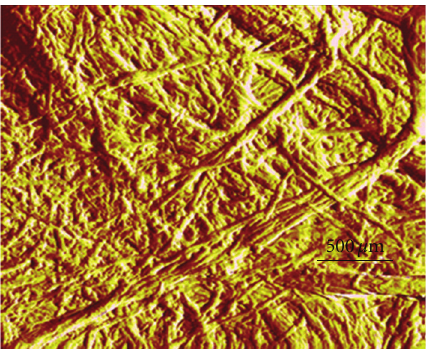
Figure 6: Atomic force micrograph of soybean stock nanofibers